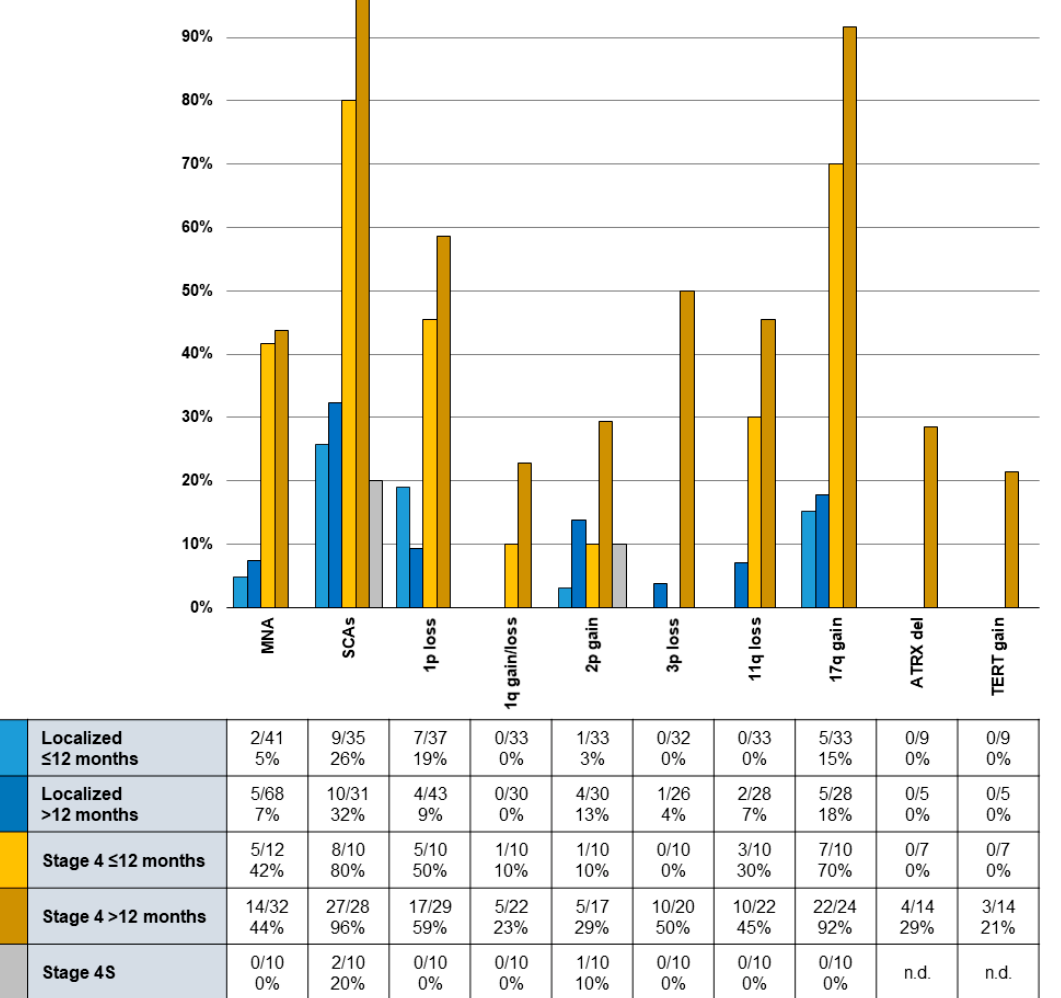
Figure 2. Presence of SCAs, ATRX deletion, and TERT gain within groups by age and stage. Presence of segmental chromosomal alterations (SCAs) that were associated with a significantly lower event-free (EFS) and overall survival (OS) in a univariate analysis within groups differentiated by age ( ≤ />12 months) and stage by International Neuroblastoma Staging System (INSS) (localized/4S or stage 4).